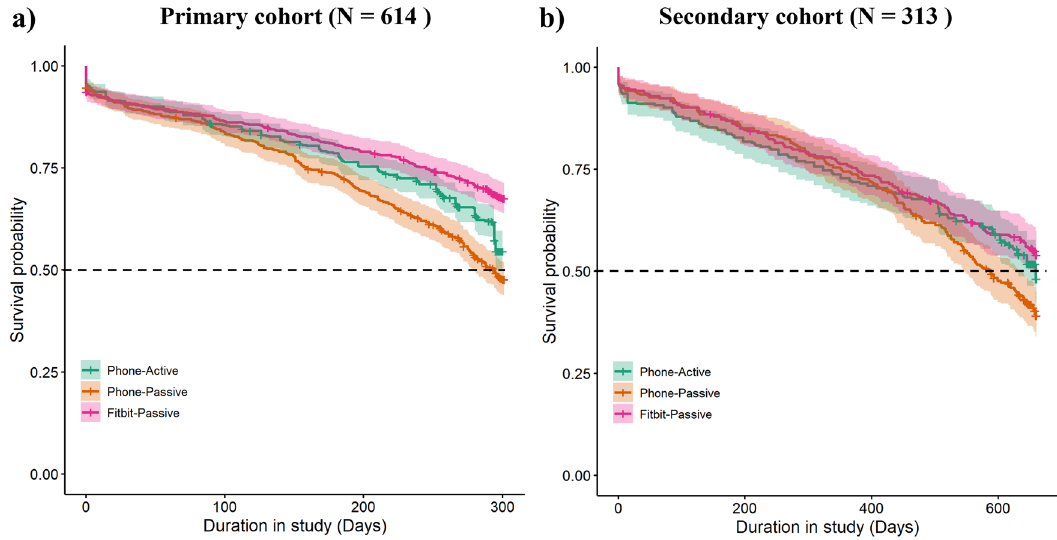
Fig. 1 Participant retention in the RADAR-MDD study. The Kaplan-Meier survival curves for ( a ) the primary cohort ( N = 614) with an observation period of 43 weeks, and ( b ) the secondary cohort ( N = 313) with a longer observation period of 94 weeks strati fi ed by Phone- Active, Phone-Passive, and Fitbit-Passive data